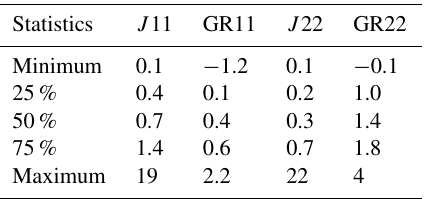
Table 3. Statistics of particle formation rates of DGR events J 11 and J 22 (cm − 3 s − 1 ) , at the nominal geometric mean diam- eters 11nm, and 22nm and corresponding diameter growth rates GR11,and GR22 (nmh − 1 ) in the two diameter ranges 5–25nm, and